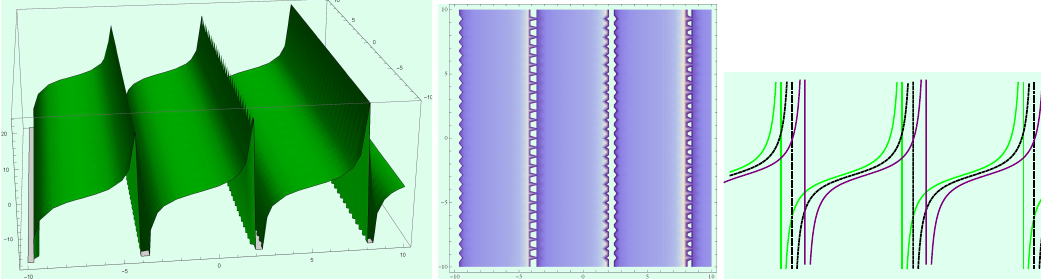
Figure 10. Profile of traveling wave solution (27) with parameters t = 1 and x = 2.